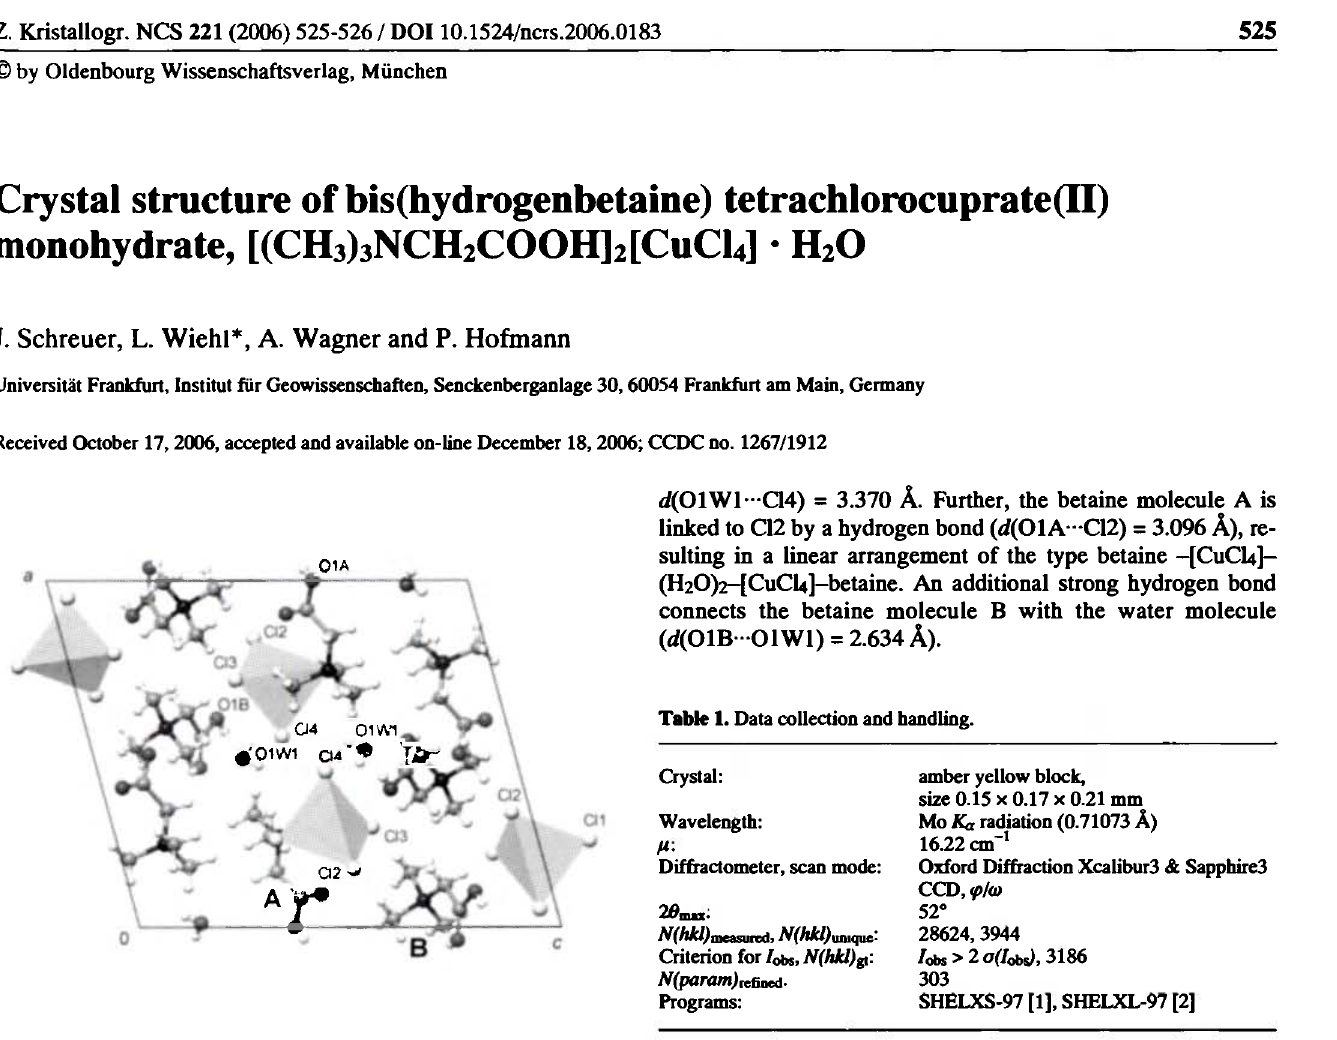
Table 2. Atomic coordinates and displacement parameters (in A 2